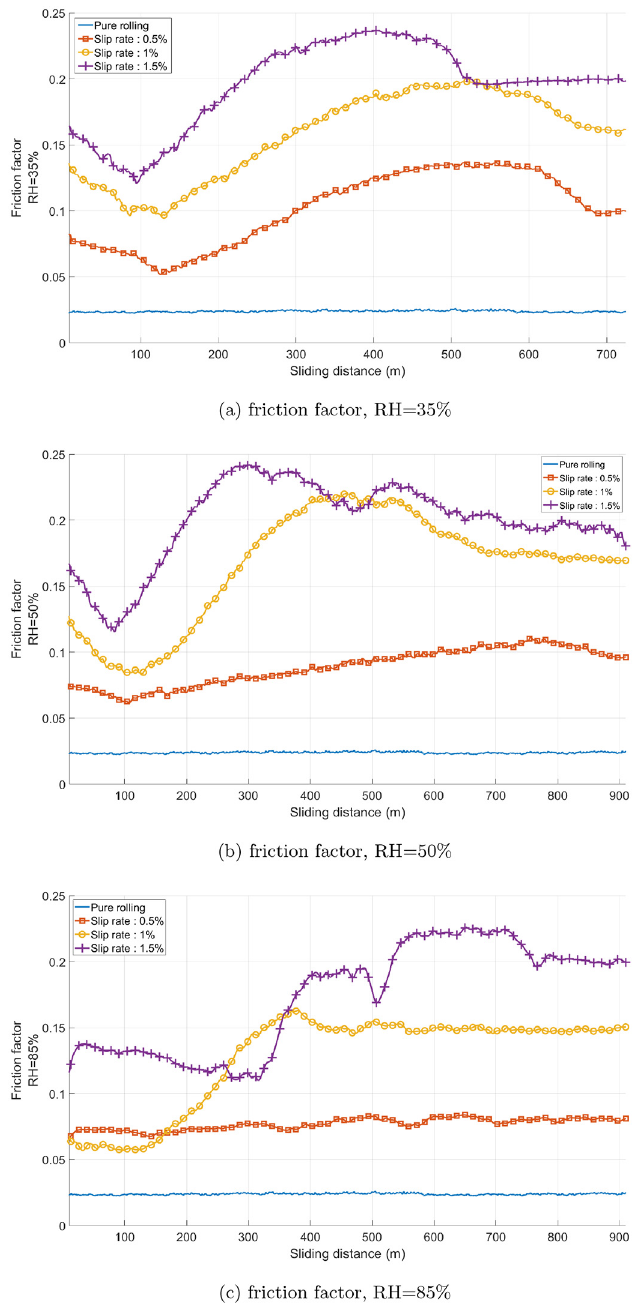
Fig. 14. Friction factor and RH of leaves (from tests performed in Tab. 4).